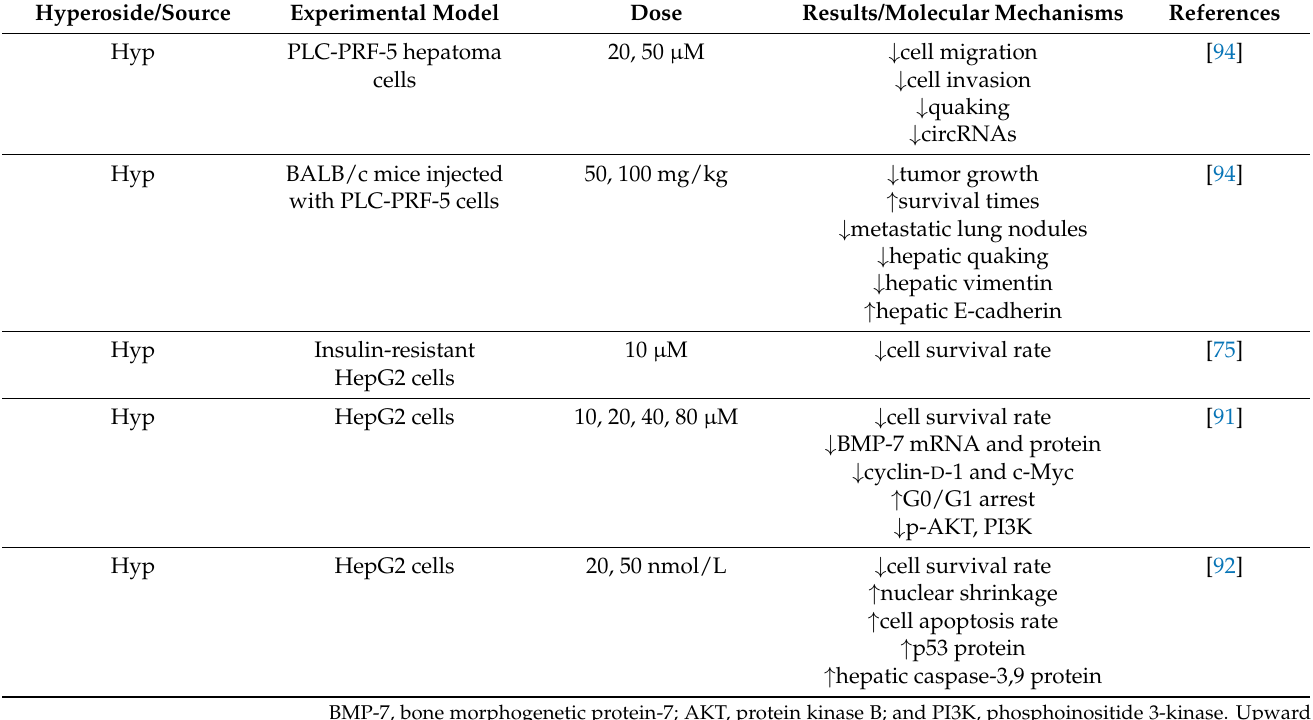
Table 6. Anticancer activities of hyperoside (Hyp) in experimental models related to hepatocellular carcinoma